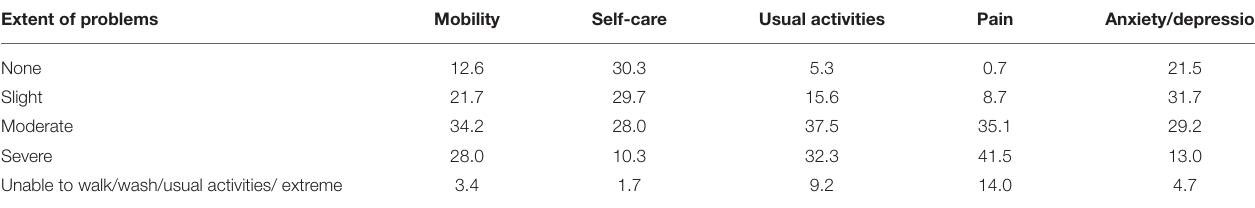
TABLE 3 | Mean scores on EQ-5D-5L dimensions among people with a primary diagnosis of chronic pain ( n = 903).